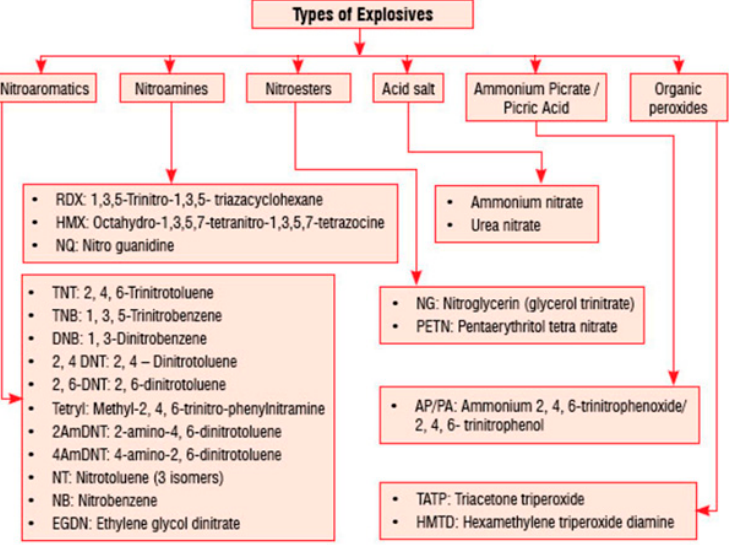
Figure 1. Classification of commonly used explosives.